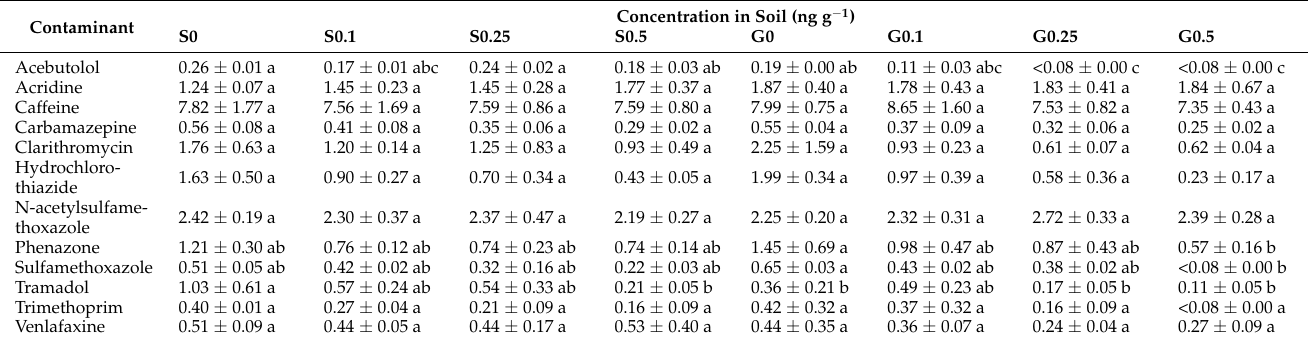
Table 4. Pharmaceutical concentrations in soil without ryegrass (S0, S0.1, S0.25, S0.5) and with ryegrass (G0, G0.1, G0.25, G0.5) after irrigation by the biochar-treated wastewater at different concen- trations (0, 0.1, 0.25 and 0.5 g L − 1 ). Values represent means ± standard deviations. Different letters